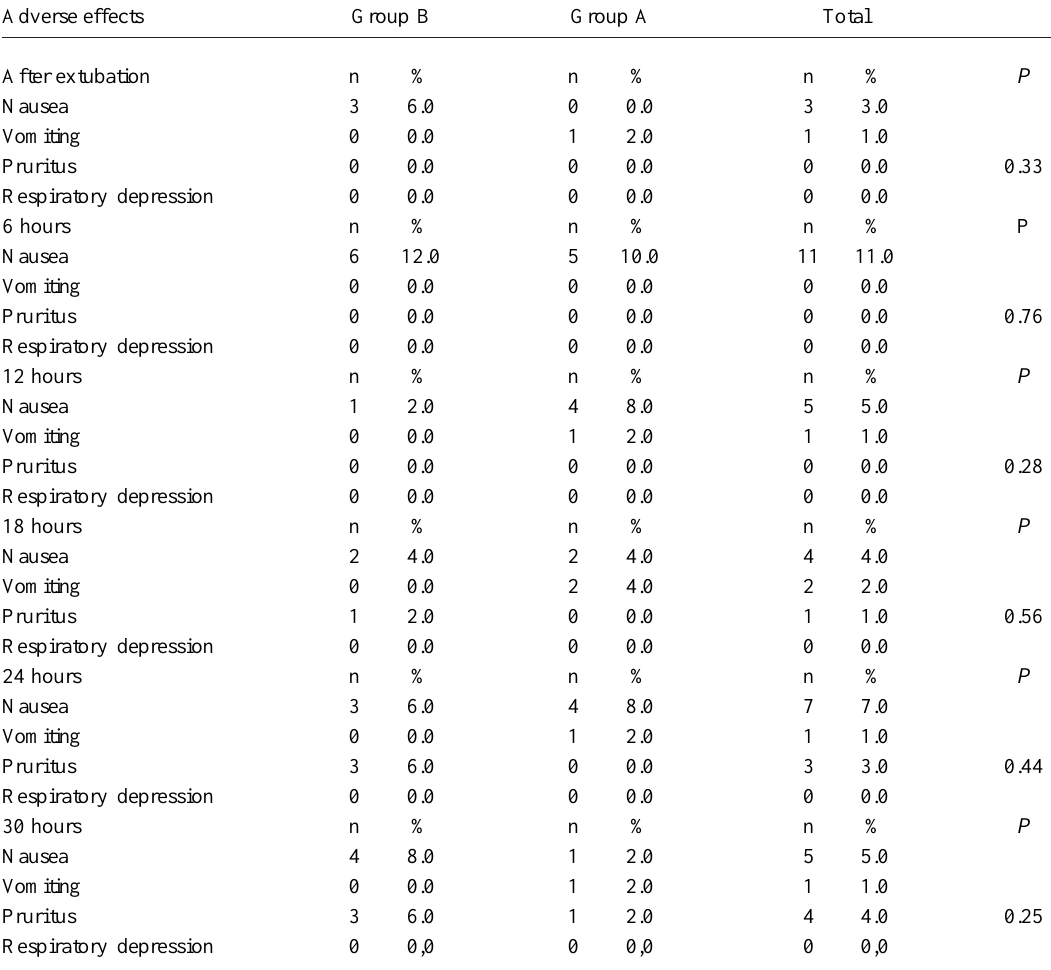
Table 4. Incidence of adverse effects in both study groups in each evaluated